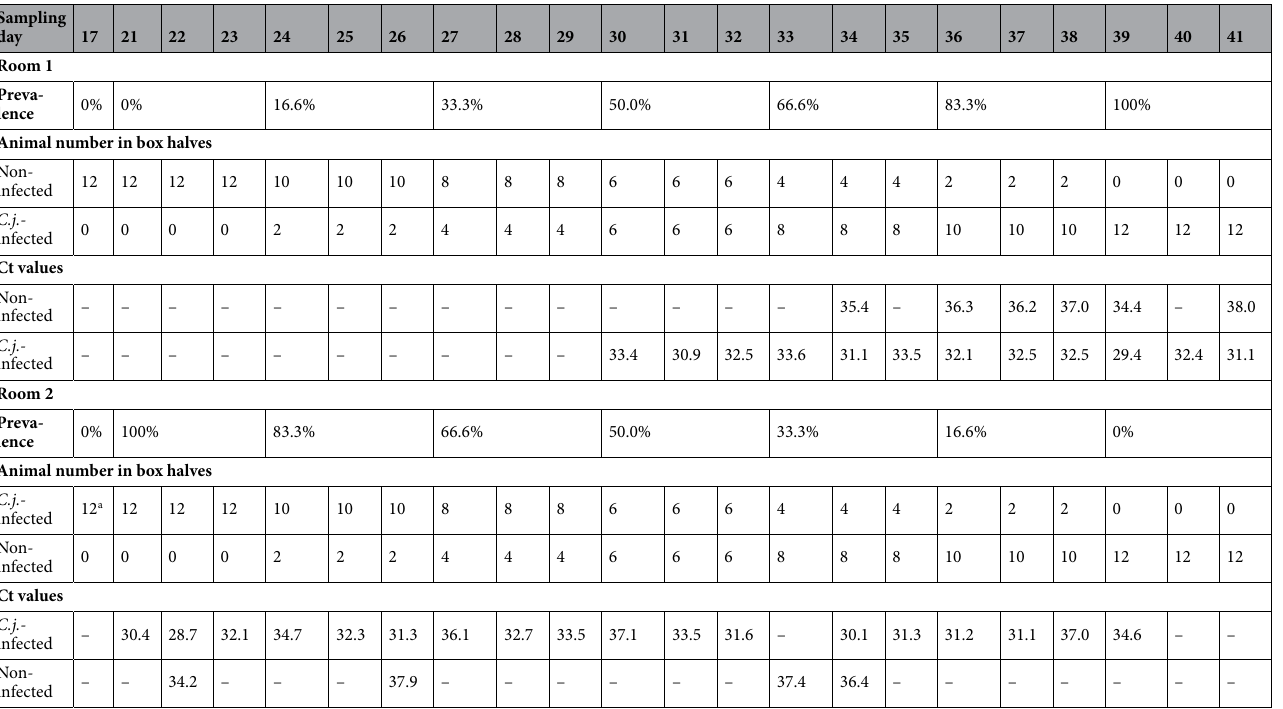
Table 3. Threshold cycle (Ct) values of PCR analyses of C. jejuni ( C.j. ) in air samples collected at non-infected and C. jejuni -infected areas in each room. a Before experimental infection.